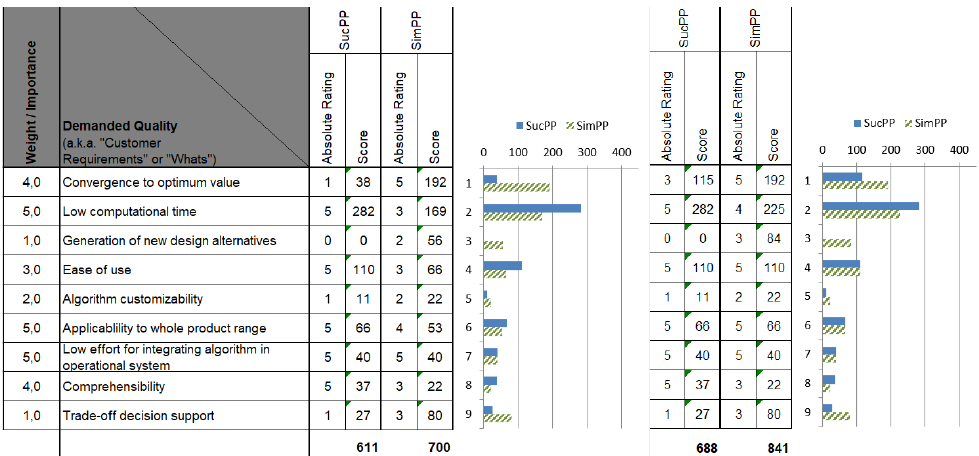
Figure 12. Decision Matrix for Boom Configuration before optimization (( left ), with Demanded Quality Criteria) and after optimization ( right ). Note that, for a better representation, only the scoring for comparing the algorithms are